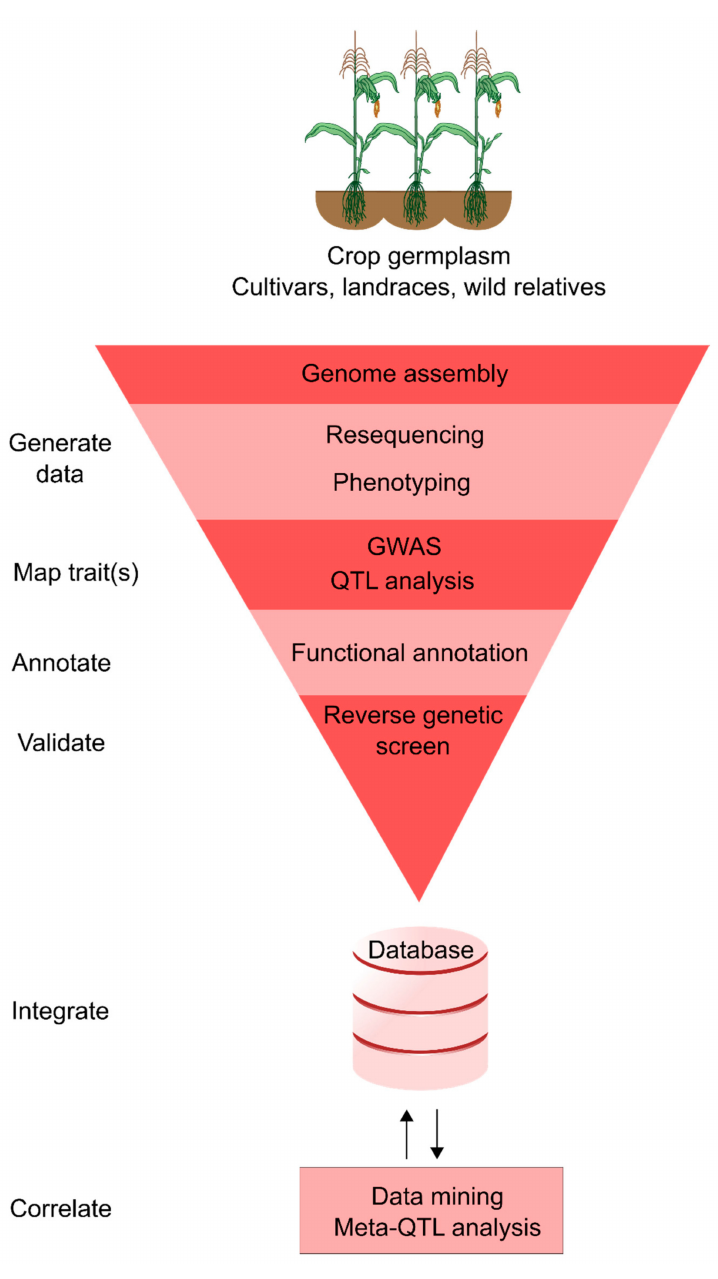
Figure 1. Schematic overview of a crop trait discovery